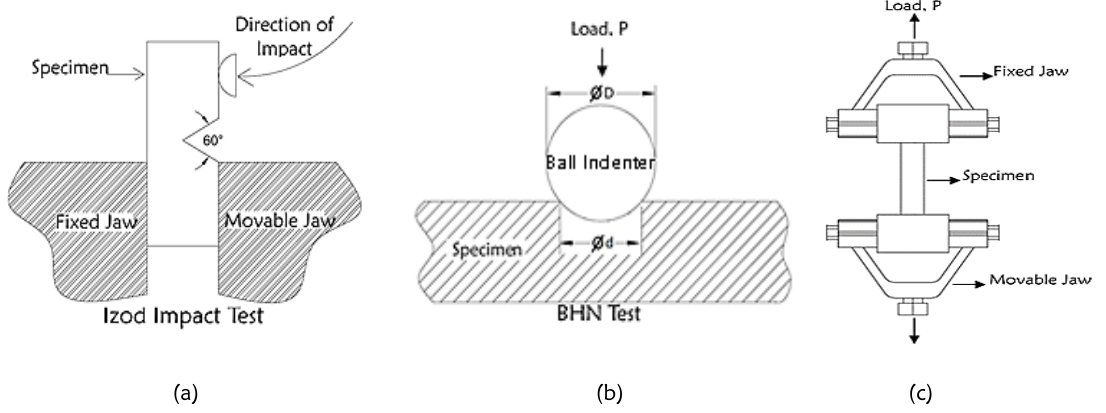
Figure 7: Evaluation process of (a) Izod impact, (b) BHN and (c) Tensile